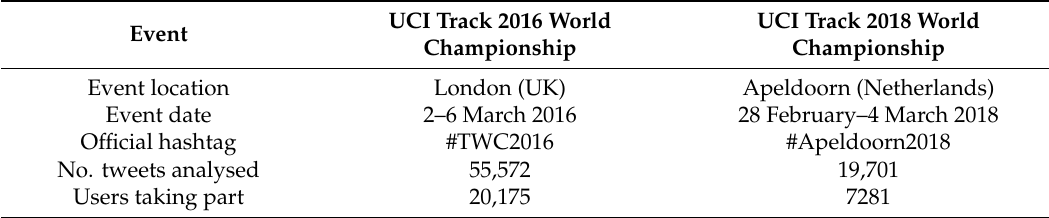
Table 3. General data of the two world championships